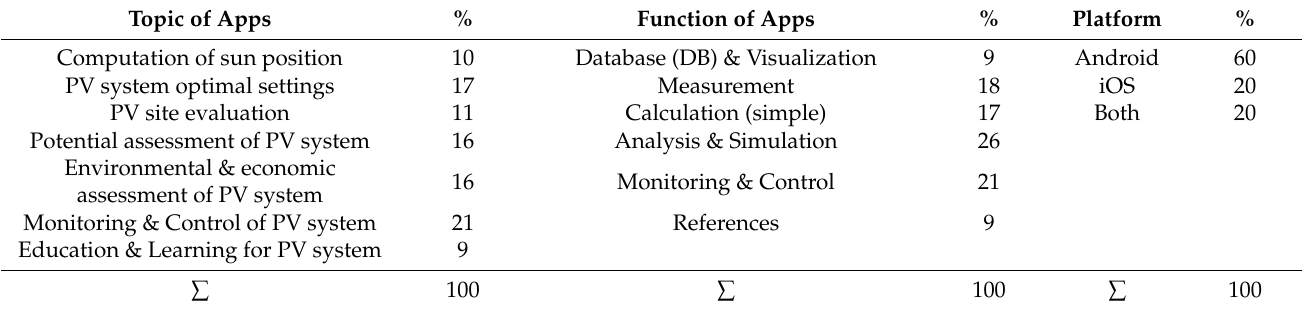
Table 2. Summary of smart-device applications for solar PV energy